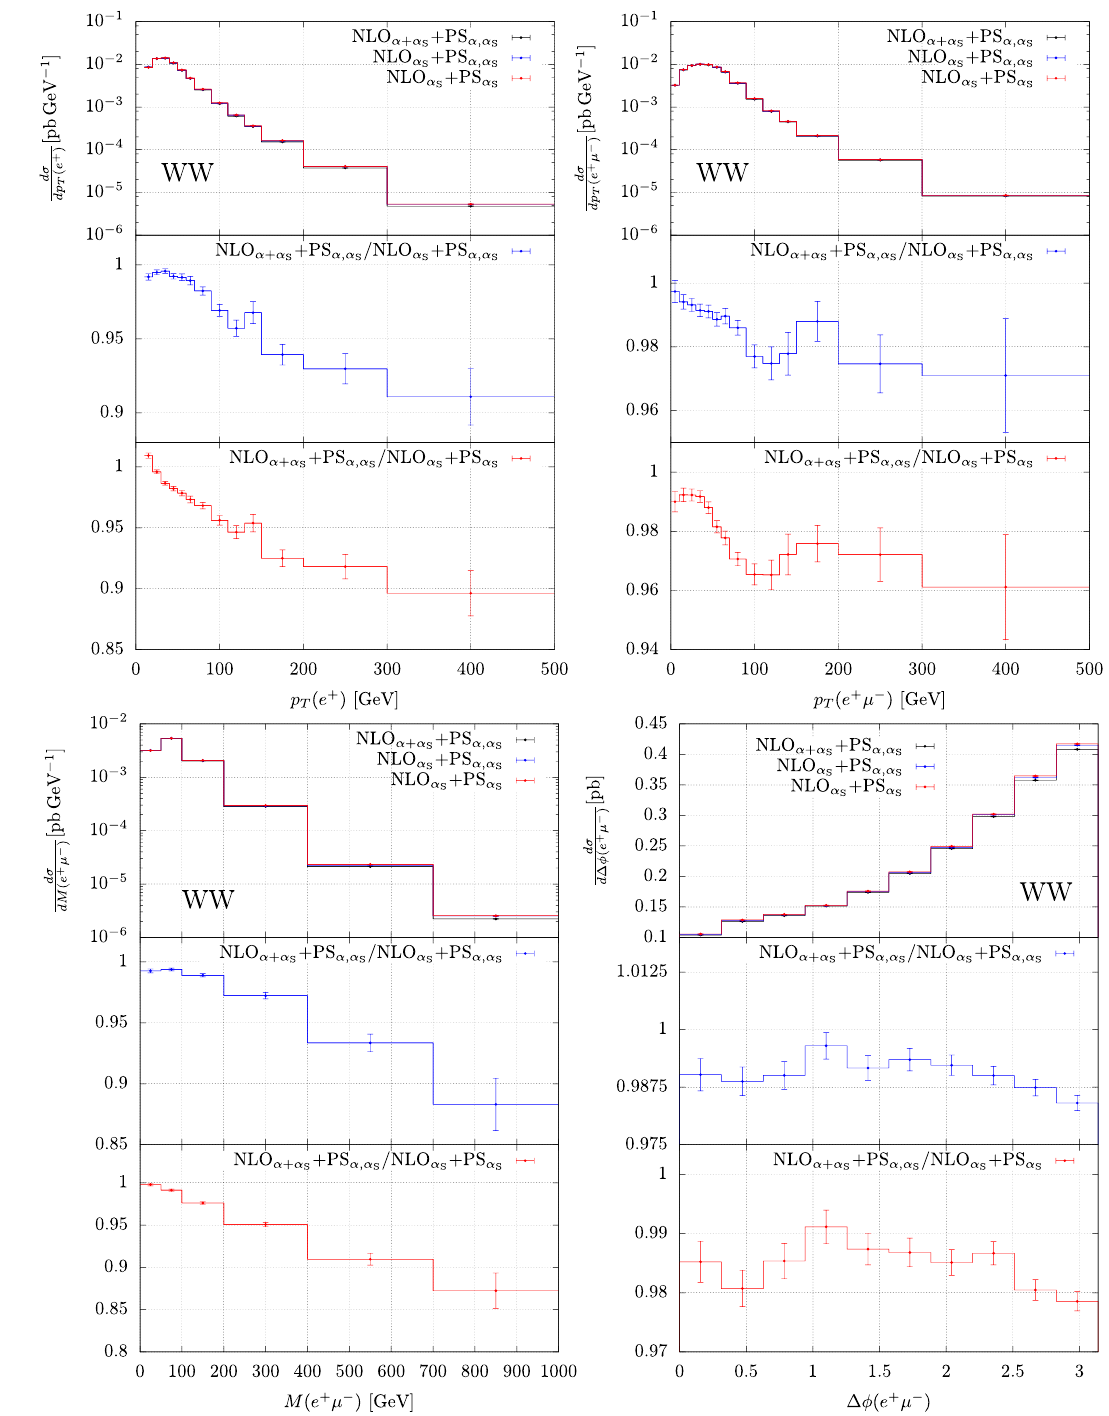
Fig. 5 Comparison of the predictions at NLO QCD + NLO EW of the positron–muon system, and of the azimuthal-angle separation between the positron and the muon (bottom right). Central panels: ratio + PS QCD , QED (NLO α + α + PS α,α ), at NLO QCD + PS QCD , QED S S of the predictions at NLO QCD + NLO EW + PS QCD , QED and at NLO QCD (NLO α +PS α,α ), and at NLO QCD + PS QCD (NLO α + PS α ) accuracy S S S S for the process pp → e + ν e μ − ν μ . Upper panels: differential distribu- + PS QCD , QED . Lower panels: ratio of the results at NLO QCD + NLO EW tions as a function of the positron transverse momentum (top left), of + PS QCD , QED and at NLO QCD + PS QCD . See main text for the transverse momentum (top right) and invariant mass (bottom left)